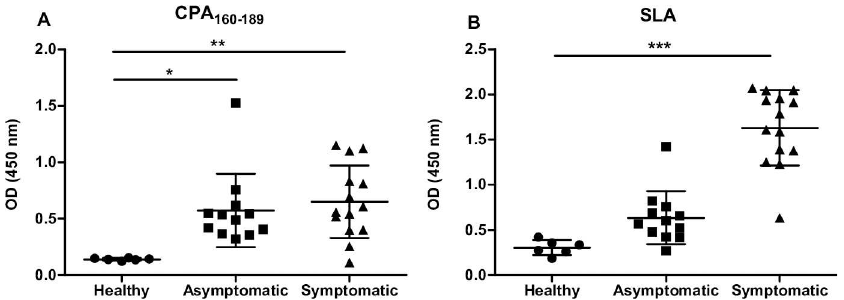
Fig 1. Evaluation of CPA 160-189 immunogenicity in naturally infected dogs. Detection of (A) CPA 160-189 - and (B) SLA-specificIgG antibodiesin sera samplesfrom asymptomatic (n = 12) and symptomatic (n = 14) L . infantum -infected and non-infectedhealthy(n = 6) dogs. Lines indicatethe mean ±